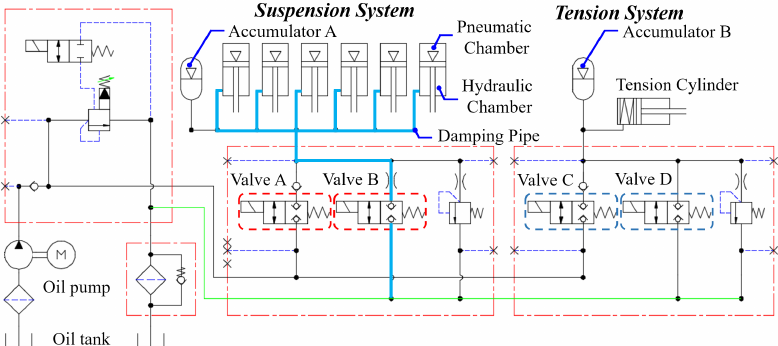
Figure 4. Hydropneumatic suspension system for the